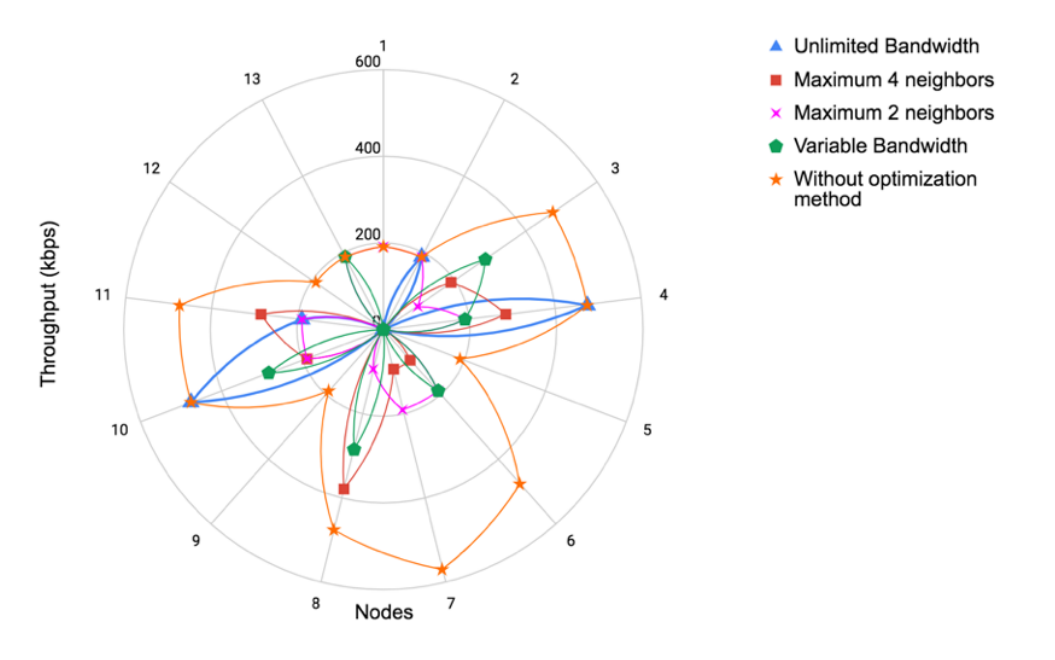
Figure 12. Throughput comparison of every sensor node among different available bandwidth using our proposed communication-reduced method vs. communication pattern